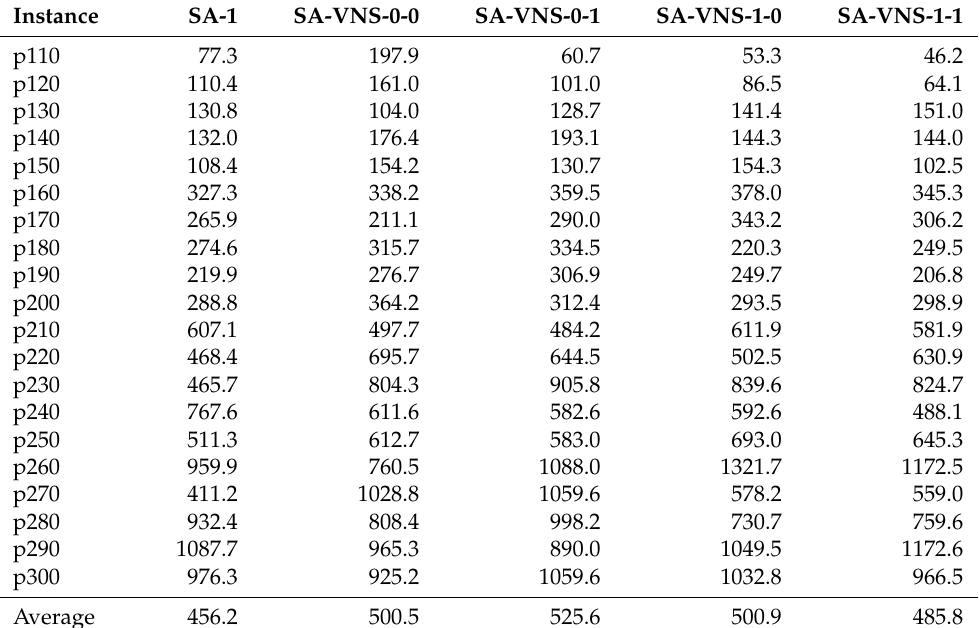
Table 5. Comparison of the average running time (in seconds) to the best solution in a run for larger problem